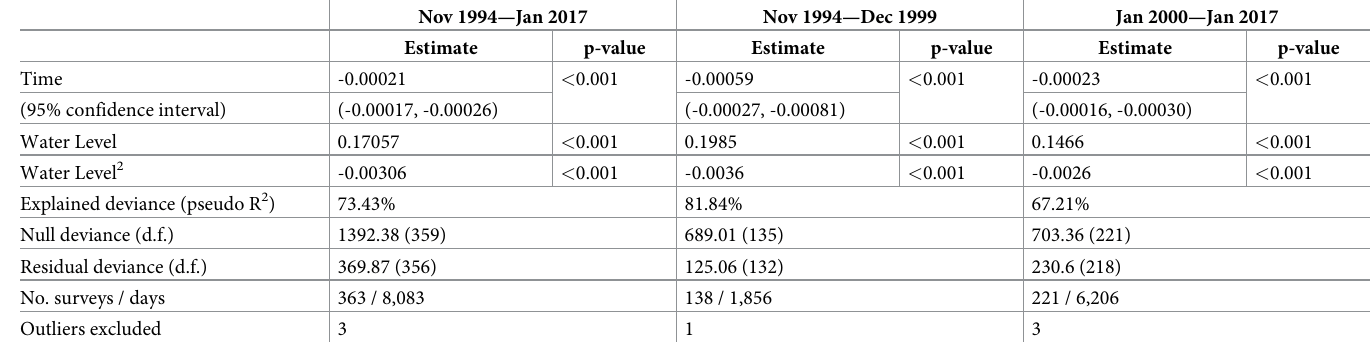
Table 2. Model results for tucuxi counts. The unit of time is one day, so a coefficient of -0.00021 represents a decline in the number of encountered tucuxis of 0.021% per day, or 7.67% per year during the entire sampling